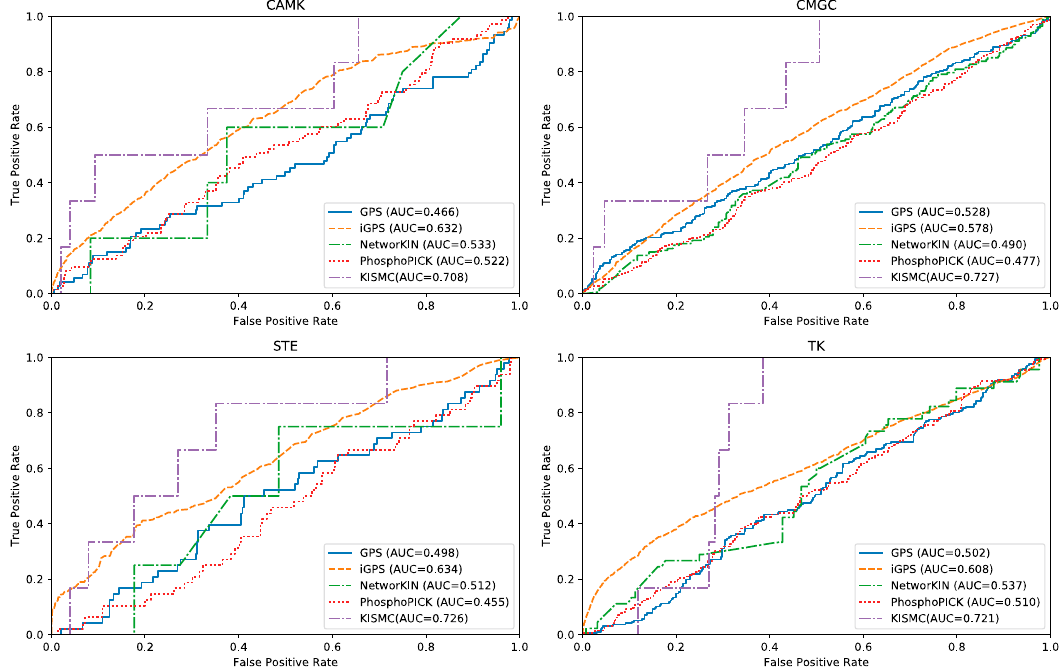
Figure 2. The ROC curves for kinase group CAMK, CMGC, STE and TK with different algorithms.